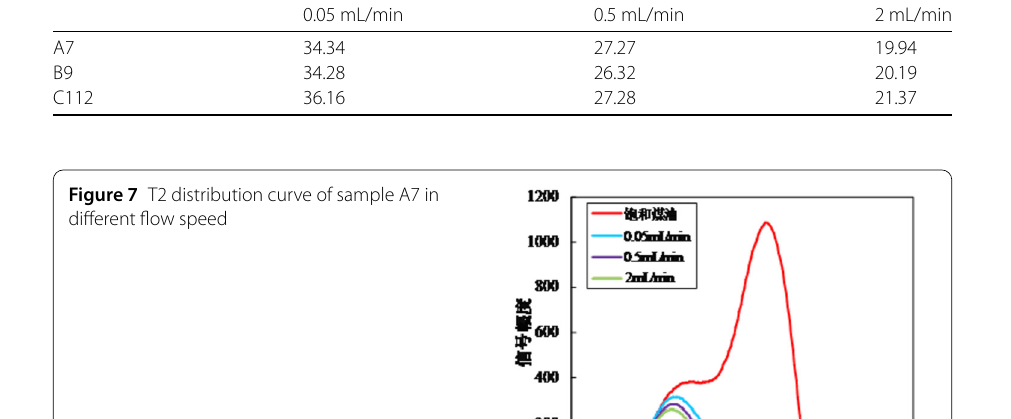
Figure 8 T2 distribution curve of sample B9 in different flow speed